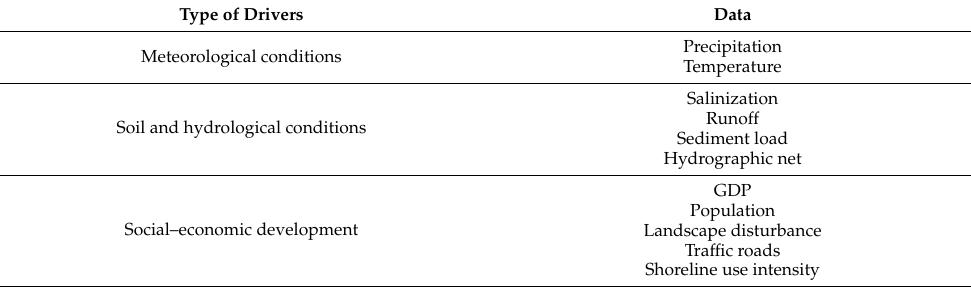
Table 5. Social–economic drivers and their sources in the Yellow River